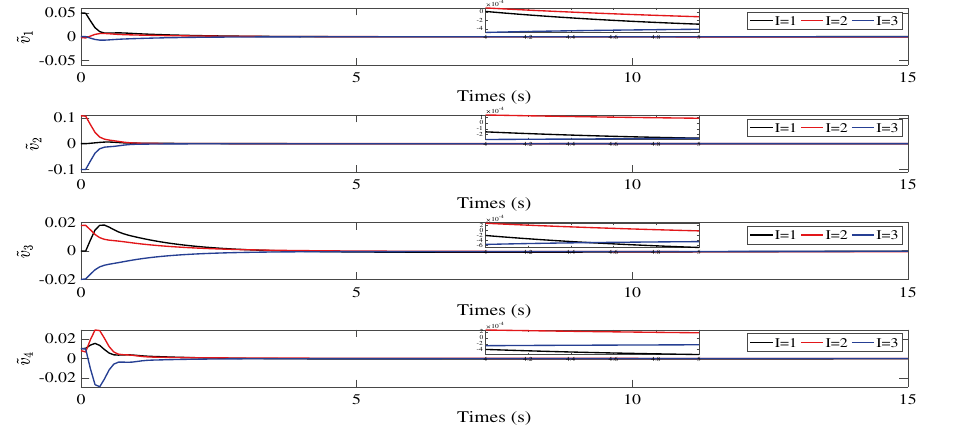
Figure 3. Estimation errors ˜ v i ( t ) .